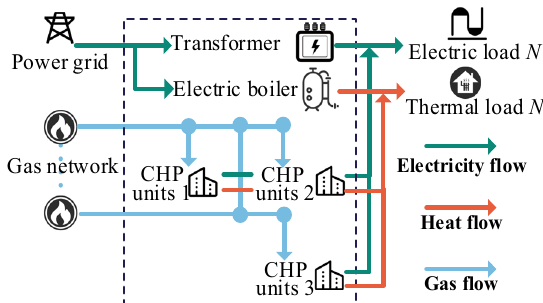
Fig. 4 Internal structure of the